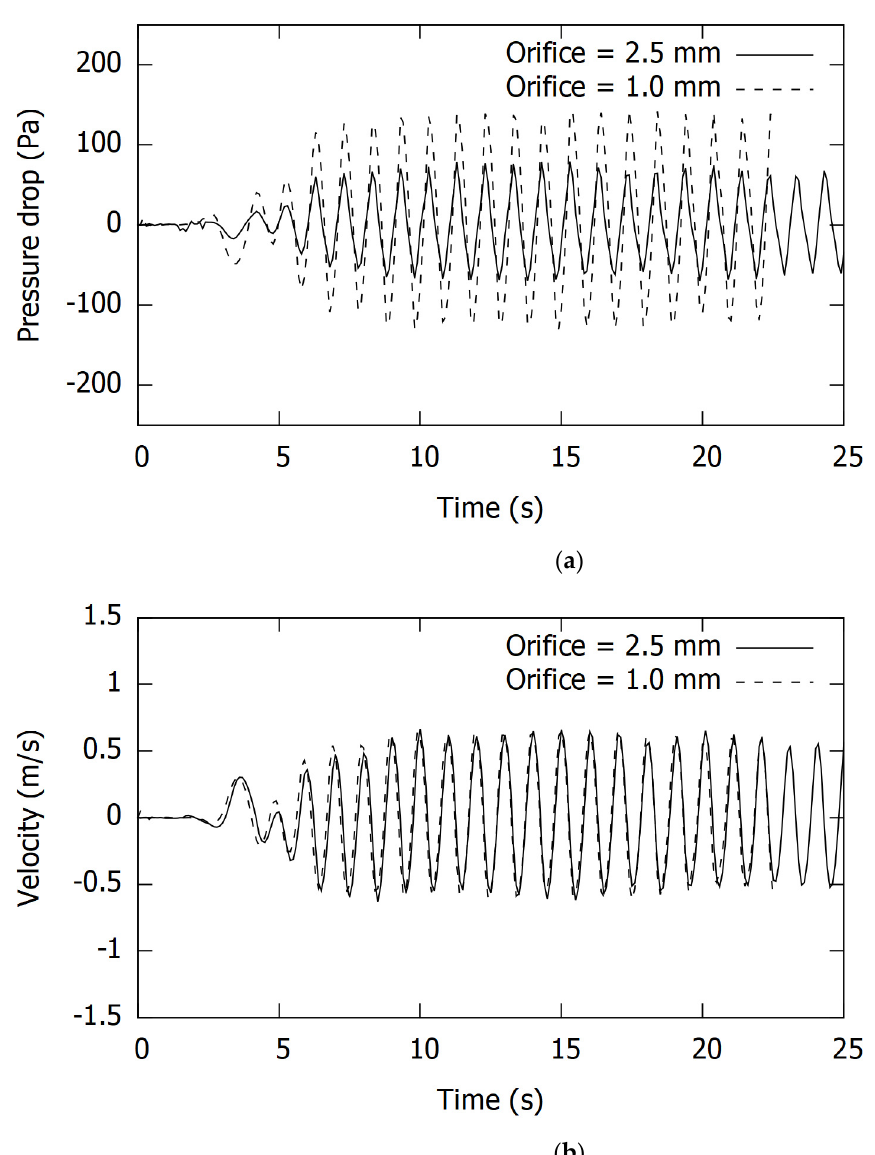
Figure 6. Effects of orifice size on the ( a ) pressure drop across the pipe ( b ) velocity through the orifice.